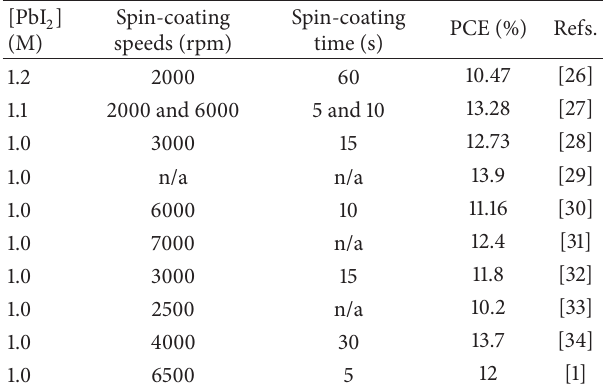
Table 3: Solution processed perovskite (CH 3 NH 3 PbI 3 ) solar cells fabricated under various